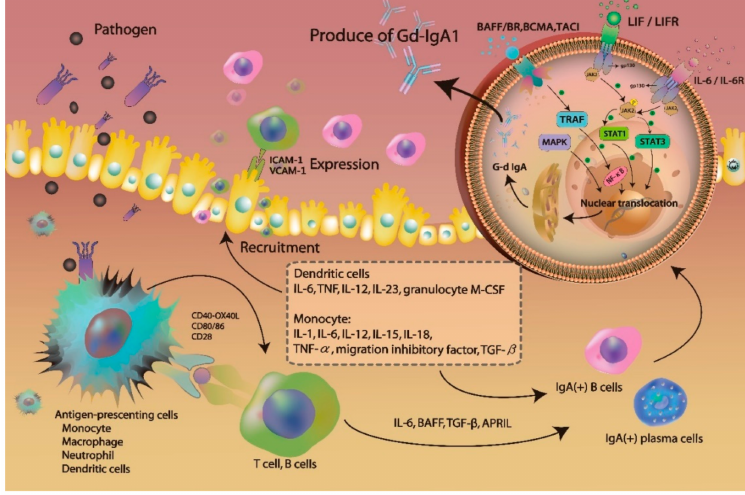
Figure 3. The mechanism of activating B cells to produce the galactose-deficient